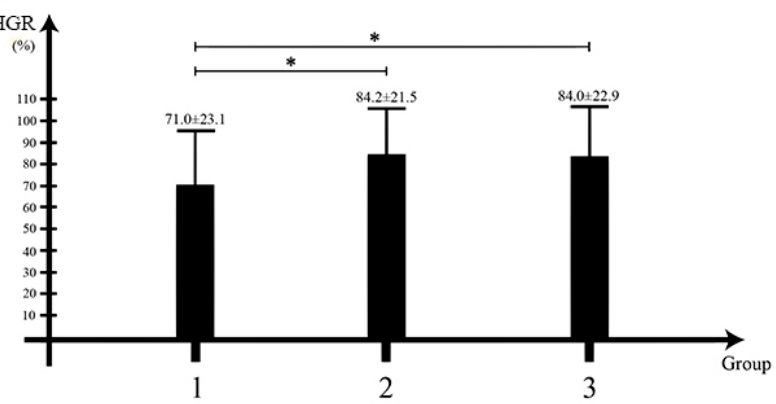
Figure 3. Comparison of the hard tissue gain rates (HGR) of the groups. There was a statistically significant difference between the rates of Groups 1 and 2, as well as Groups 1 and 3. HGR, the percentage of HG compared with BA (HG/BA); BA, bone augmentation immediately after surgery; HG, hard tissue gain after 6 months of healing; Group 1, only three-dimensional preformed titanium mesh (3-D-PFTM) used; Group 2, 3-D-PFTM + cross-linked collagen membrane used; Group 3, 3-D-PFTM + non-cross-linked collagen membrane used. * Statistically significant difference ( p < 0.05; Kruskal–Wallis test).